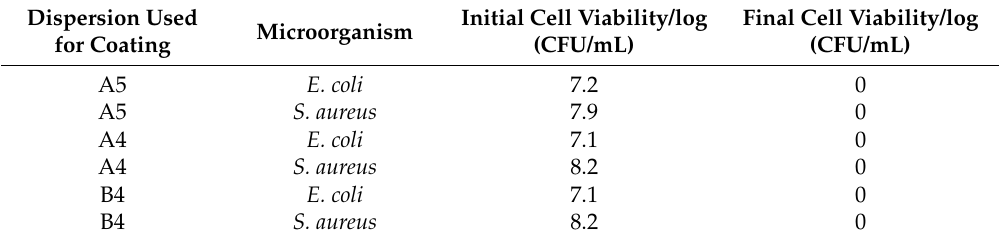
Table 2. Microbicidal activity of PMMA/PDDA coatings obtained from casting and drying under the concentrations used for particle synthesis, in 0.2 mL of each dispersion used for the coatings there will be 0.8 to 1.0 mg of PDDA acting against the